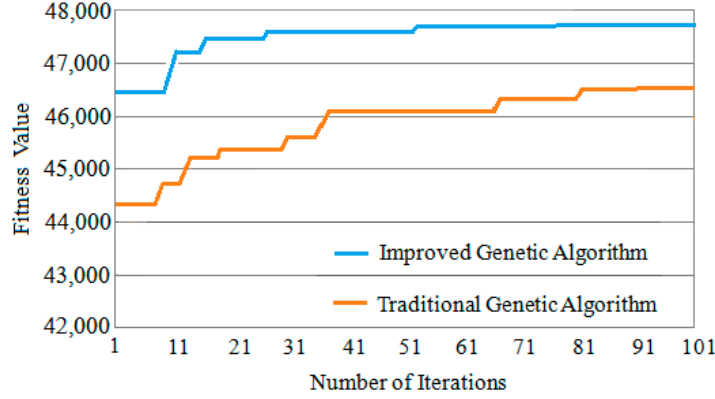
Figure 12. Convergence speed comparison of DVOPD.